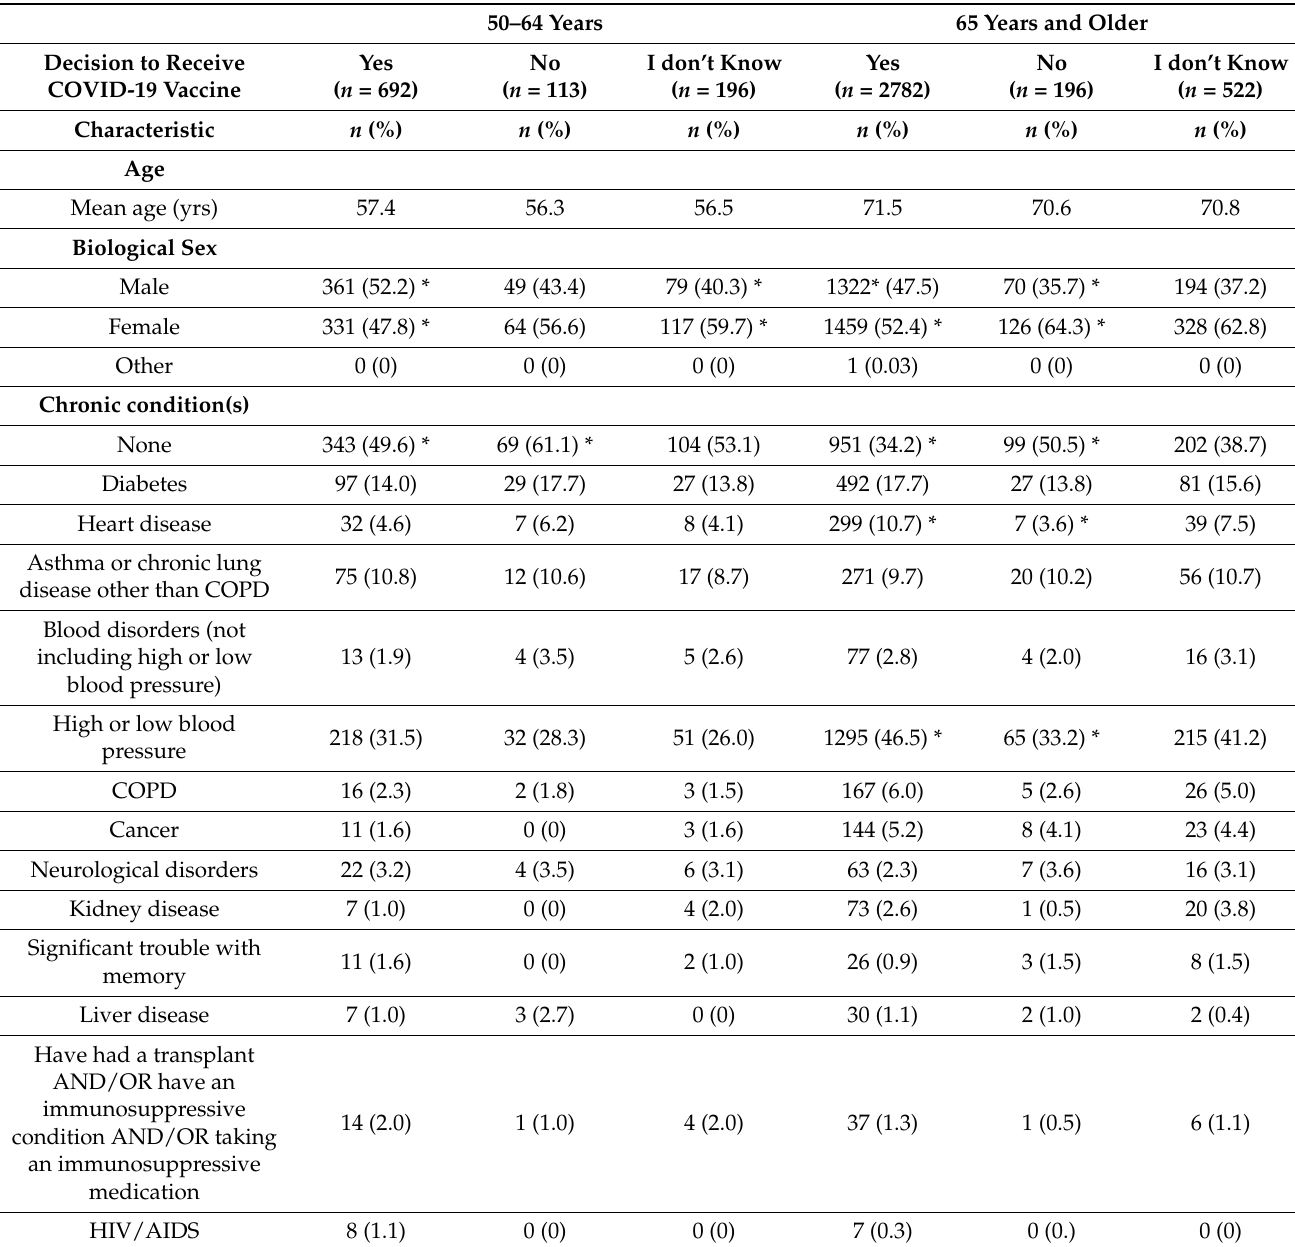
Table 4. Characteristics of respondents based on reported willingness to reeive the COVID-19, by age group. 50–64